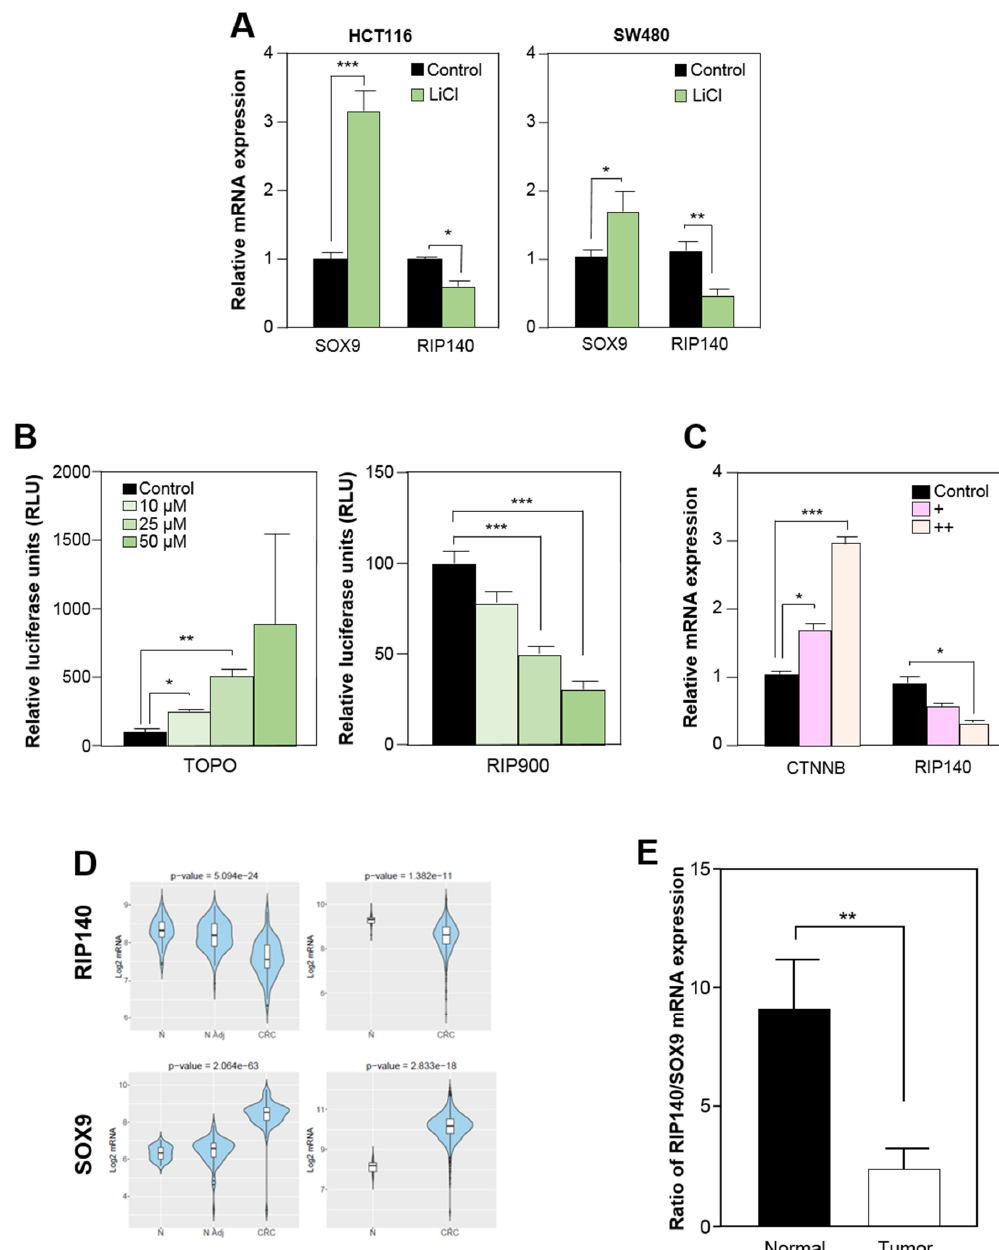
Figure 3. ( A ) RT-qPCR analysis of RIP140 and SOX9 expression in HCT116 (left panel) and SW480 (right panel) CRC cells after LiCl treatment (50 µM) for 24 h. The results are expressed in arbitrary units after normalization by 28S mRNA levels. Values are the means ± SEM of 3 independent experiments. ( B ) HCT116 cells were transfected with a β -catenin responsive reporter plasmid (left panel) or with RIP140 gene promoter reporter vector (right panel) and treated with a dose-response of LiCl. Relative luciferase activity was expressed as the mean ± SEM; n = 3. ( C ) RT-qPCR analysis of RIP140 and CTNNB expression after ectopic expression of TCF and β -catenin. The results are expressed in arbitrary units after normalization by 28S mRNA levels. Values are the means ± SEM of 3 independent experiments. ( D ) Analysis of RIP140 and SOX9 mRNAs expression in non-tumoral (N), CRC-adjacent non-tumoral tissues (N Adj), and CRC specimens in two different cohorts (GSE44076 on the left panel and GSE39582 on the right panel) using the CANCERTOOL database. Data are presented as violin plots showing the expression of the gene of interest ( p -values are indicated). The Y -axis represents the Log2-normalized gene expression. ( E ) RIP140 and SOX9 mRNA levels expressed in arbitrary units (AU) after normalization to actin mRNA levels in 24 matched normal and tumor colon samples (means ± SEM). A Student t test was used for statistical analysis: * p < 0.05, ** p < 0.01 and *** p <